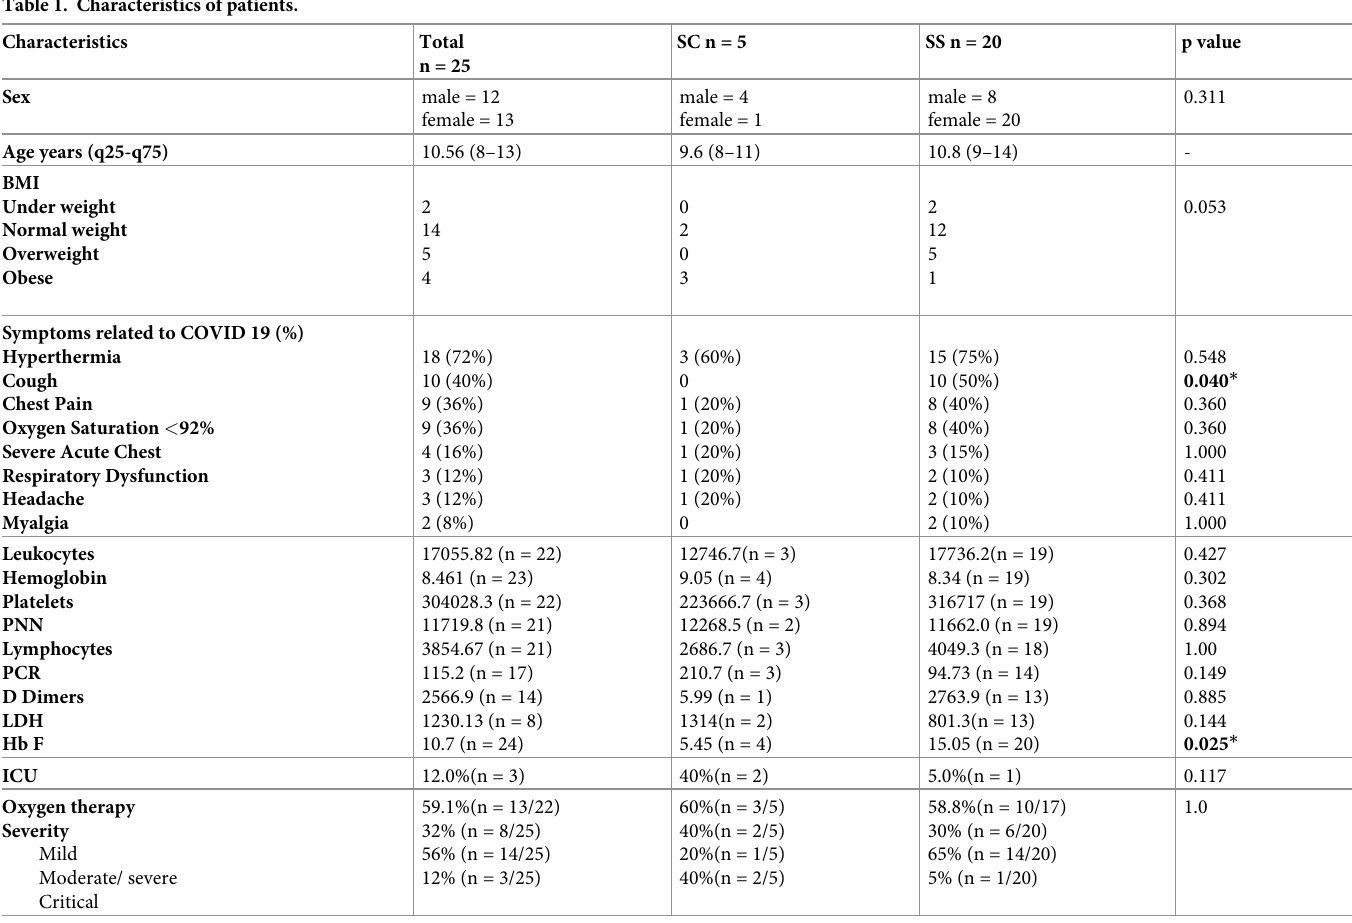
Table 1. Characteristics of